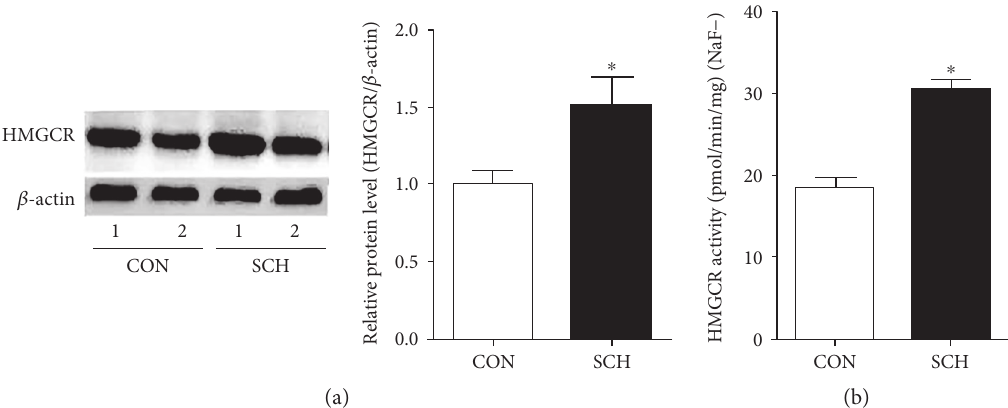
Figure 2: The expression and activity of HMGCR increased in the livers of SCH mice. (a) The expression of HMGCR protein was assessed using western blotting. (b) The activity of HMGCR in liver microsomes was determined by LC-P-ESI-MS/MS. Data were compiled from at least three independent experiments with triplicates in each experiment. ∗ p < 0 05 versus control mice.